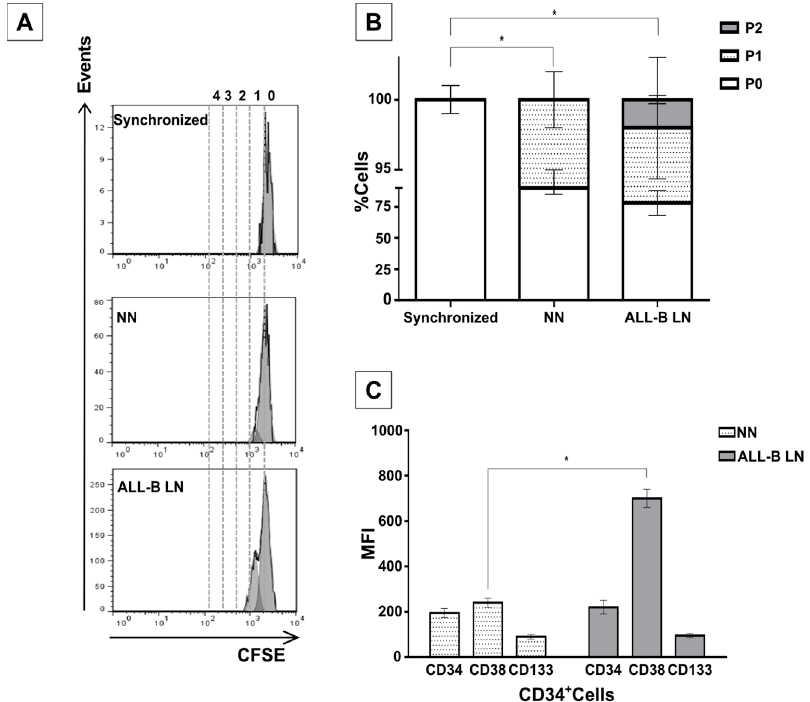
Figure 6. Increased proliferation and abnormal differentiation of CD34 + in a LN established with leukemic blasts from an ALL-B patient. ( A ) CD34+ cells isolated from an UCB sample and co-cultured with MSC pre-exposed to primary leukemic cells showed higher proliferation in the LN than in the NN. Synchronized cells are shown for comparison. A representative experiment is shown; ( B ) quantification of cells division in all settings are shown; and ( C ) mean fluorescence intensity (MFI) of the CD34, CD133 and CD38 markers in HSC co-cultured in the NN or in the ALL-B-LN. Data were obtained from two independent experiments done in duplicate ( n = 4) (* p < 0.05).